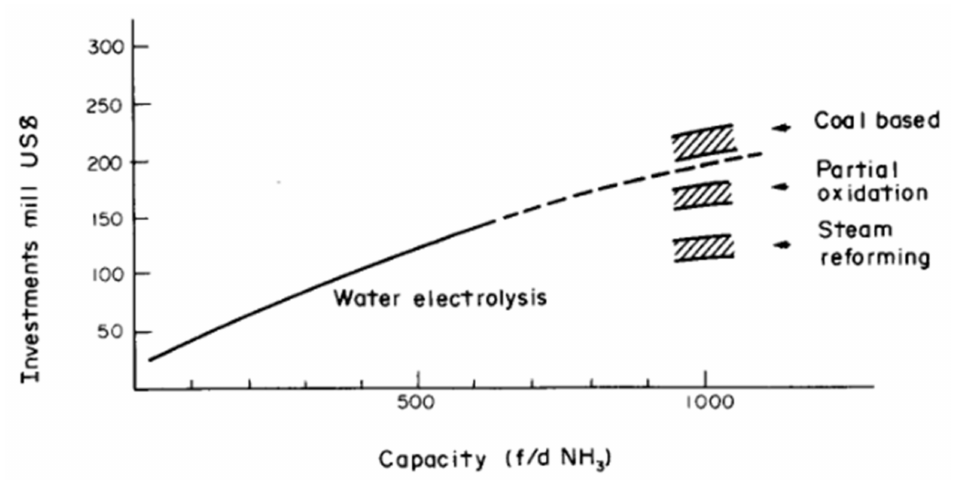
Figure 12. Indicative investment cost of various ammonia synthesis technologies. Reprinted with permission from Ref. [35]. 1982,